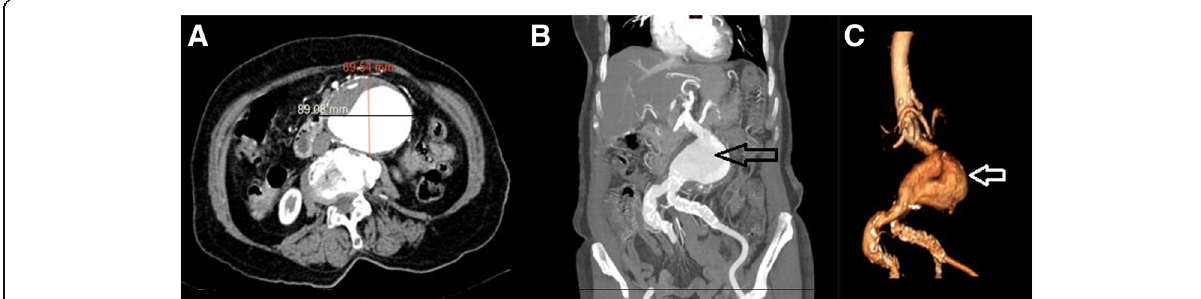
Fig. 2 Contrast Tomography Angiography (CTA) in a 66 year old woman. Axial view ( a ) demonstrates a maximum diameter of 89 mm (mm) and antero-posterior diameter of 69 mm. Coronal View ( b ), and three dimensional (3D) reconstruction ( c ) black and white arrows indicate the aneurysm